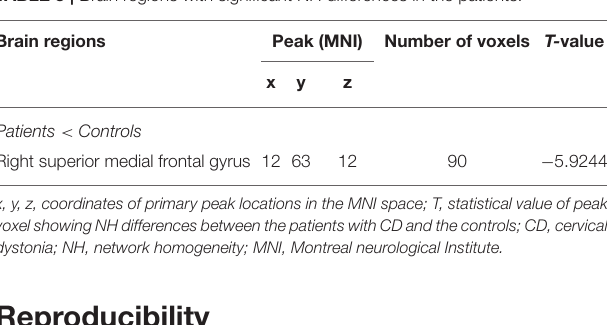
TABLE 3 | Brain regions with significant NH differences in the